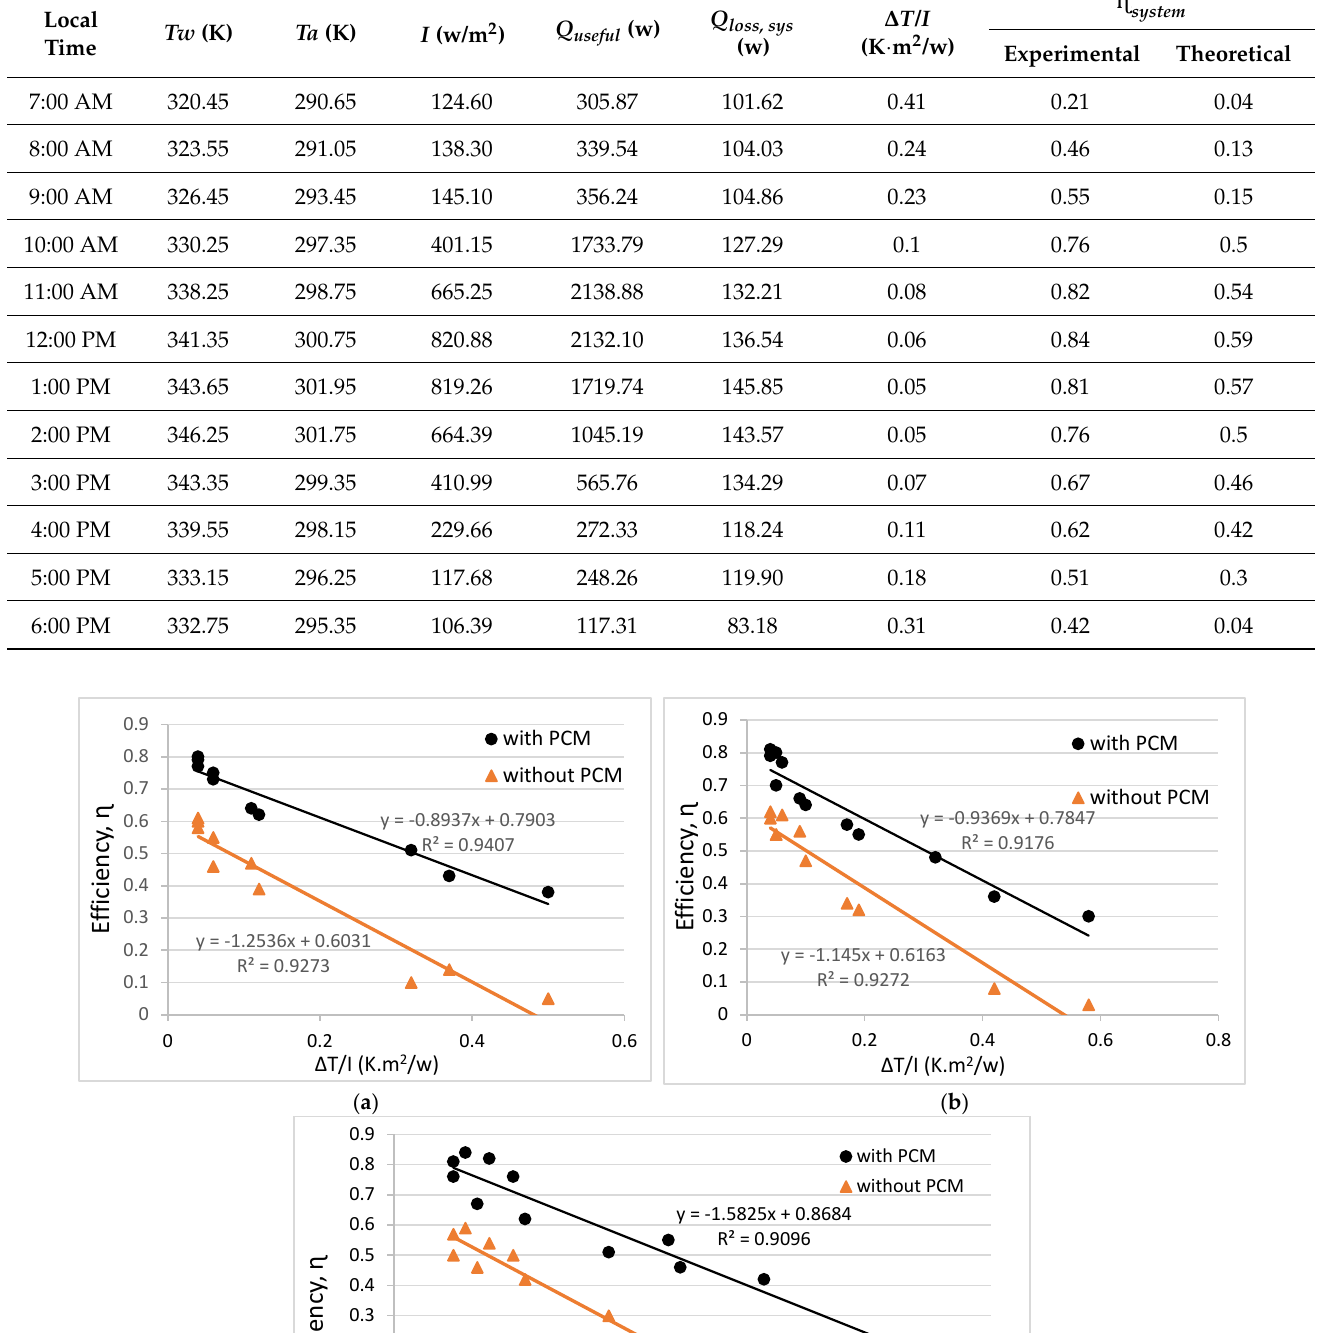
Figure 11. Efficiency of the system versus ΔT/I with and without PCM; ( a ) December, ( b ) March and ( c ) June.